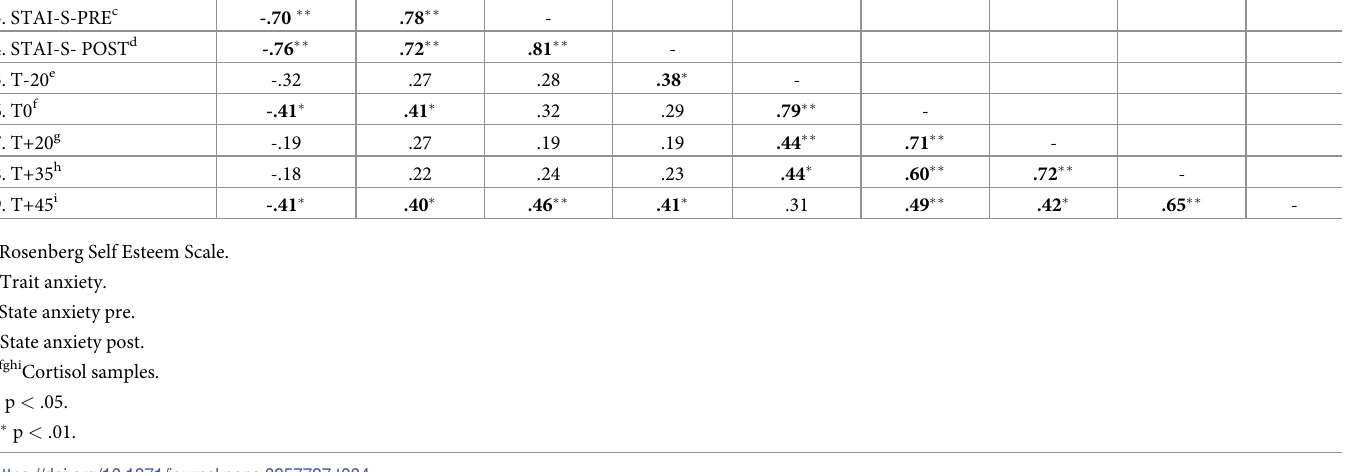
scores obtained on meaning and total accuracy for Text 1 and the number of translated words in Text 2 and Text 3. The cortisol level in t+20 correlated negatively with the score for meaning in Text 1, and the cortisol levels in t+35 and t+45 were positively correlated with the score for